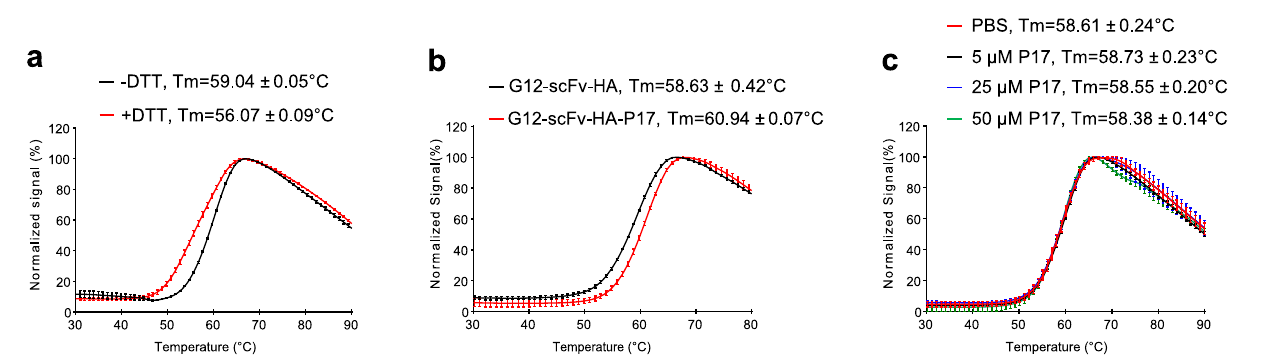
Fig. 8 | P17 tag increased thermostability of G12-scFv. a Reduction of intrado- main disul fi de bonds of G12-scFv-HA protein by DTT decreased melting tempera- ture(Tm).Five μ MG12-scFv-HAprotein,treatedwith5mMDTTfor30minatroom temperature or not, was mixed with 1× SYPRO Orange. The fl uorescence signal emitted at 570nm by SYPRO Orange at each temperature was recorded by a QuantStudio PCR apparatus and normalized to the maximal signal reached which was set at 100%. Tm of scFv was determined by three independent thermal shift